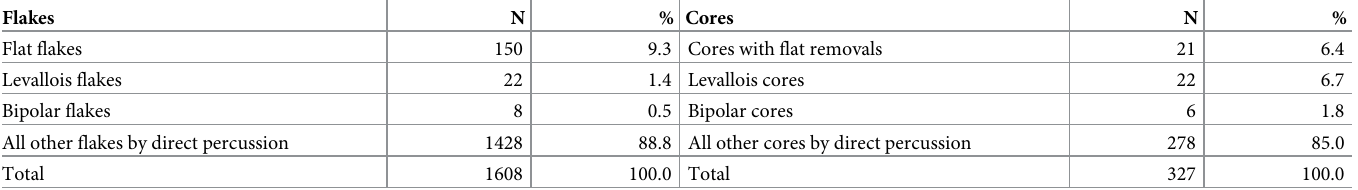
Table 5. Sant’Agostino layer A1. Counts of debitage and cores . Broken flakes without a platform, flakes < 1.5 cm and chunks are excluded. Tool retouch flakes of any size are included.